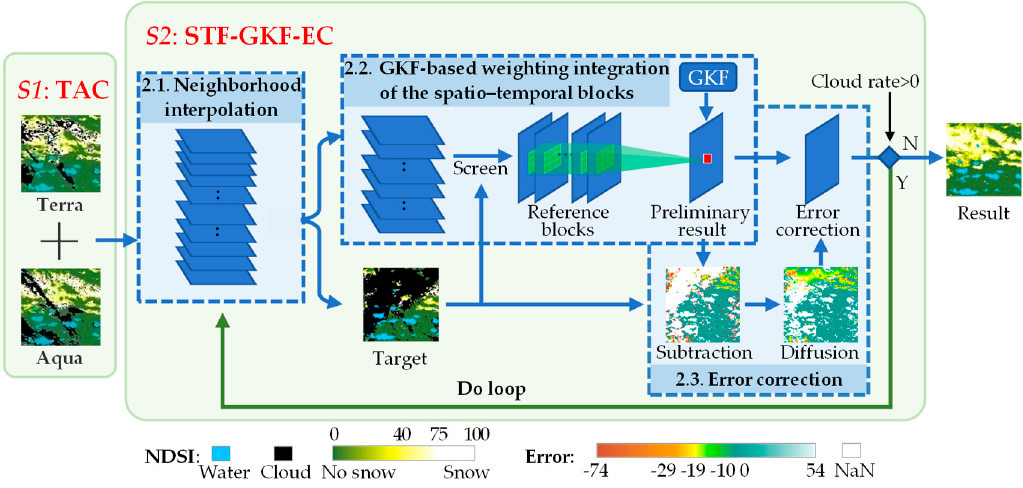
Figure 2. Flowchart of the proposed method. Note: TAC represents the Terra and Aqua combination; STF-GKF-EC represents the spatio–temporal fusion based on Gaussian kernel function and error correction.